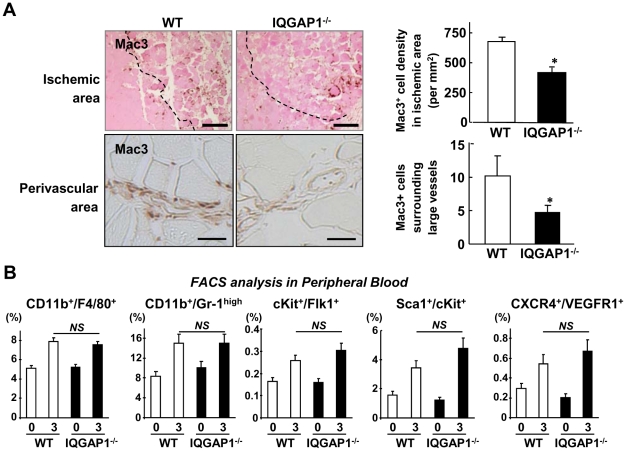
Macrophage infiltration into ischemic muscle, but not its mobilization into circulation, is impaired in IQGAP1−/− mice.A, Immunostaining of Mac3 (monocyte/macrophage marker) in ischemic muscles from WT or IQGAP1−/− mice at day 3. Upper, Mac3 positive cells in ischemic area lacking the original integrity of myofibers on eosin staining (upper left). The border of ischemic area is shown by dotted lines. Bars represent 100 µm. The density of Mac3 positive cells localized in the interstitium were determined (upper right, n = 3, *p<0.05). Lower, Mac3 positive cells in perivascular area of vessels in semimembranosus muscles (lower left). Bars represent 20 µm. The number of Mac3 positive cells distributed in the adventitia and the connective tissue surrounding the large vessels (>50 µm of diameter) were counted (lower right). B, Peripheral blood was obtained at day 0 (no ischemia surgery) and day 3. Total leukocytes were stained by fluorescence-conjugated various antibodies as indicated and analyzed by flow cytometory (n = 3 or 4 in each group). The data is expressed as the percentage of cells in total circulating leukocytes. Data shown are mean+/−SEM.